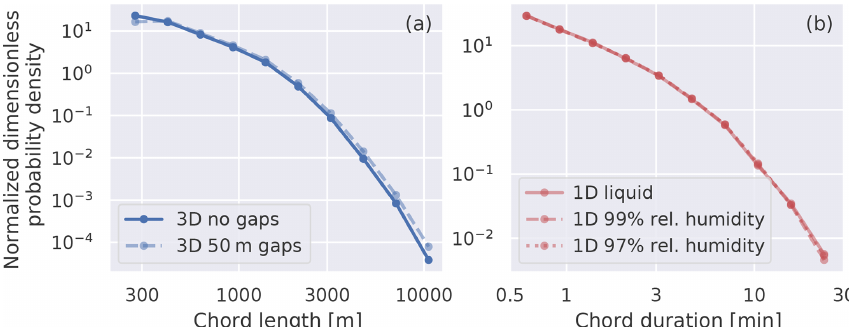
Figure 7. Distributions of (a) chord length from 5 simulations and (b) cloud chord duration from 15 simulations. The standard chord definitions introduced in Sect. 3 were modified to test the sensitivity of the results to allowing 50m gaps in 3D chords (a) and replacing the cloud definition with a relative humidity threshold (b) .